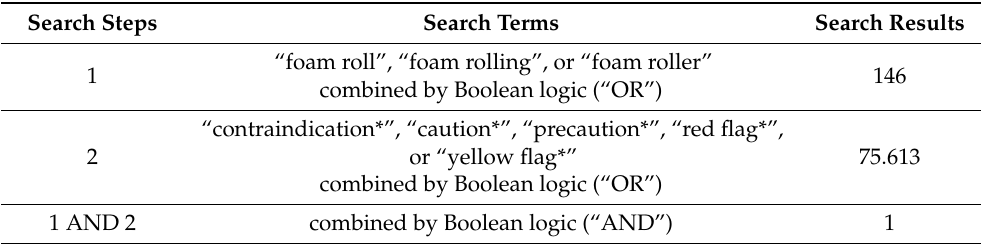
Table 1. PubMed literature search on contraindications and cautions of foam rolling. The search was limited to human subjects and performed on 2 November